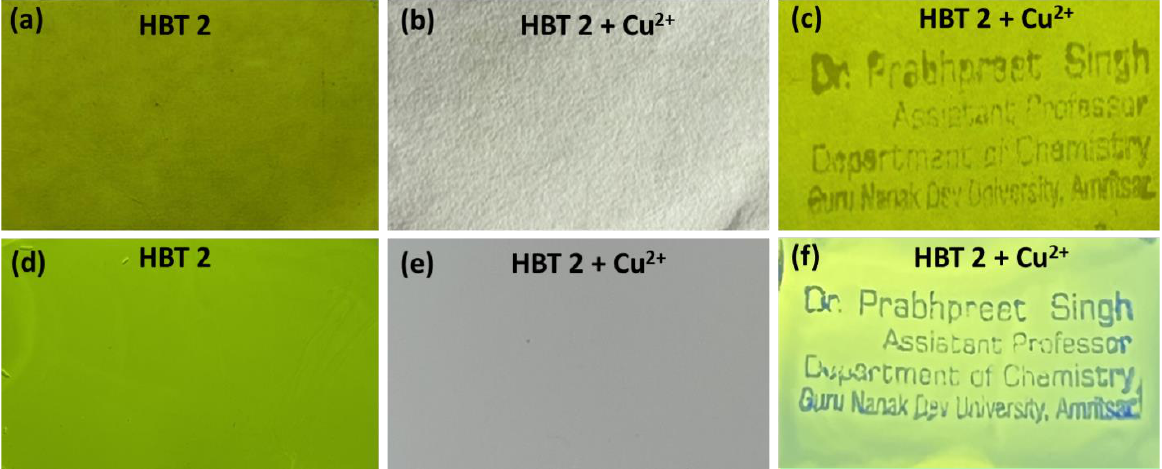
Figure 8. Photographs of HBT 2 (under 365 nm UV lamp) alone; HBT 2 after stamping with Cu 2+ ink under daylight and 365 nm UV lamp taken on ( a – c ) filter papers and ( d – f ) TLC strips for developing anticounterfeiting labels.